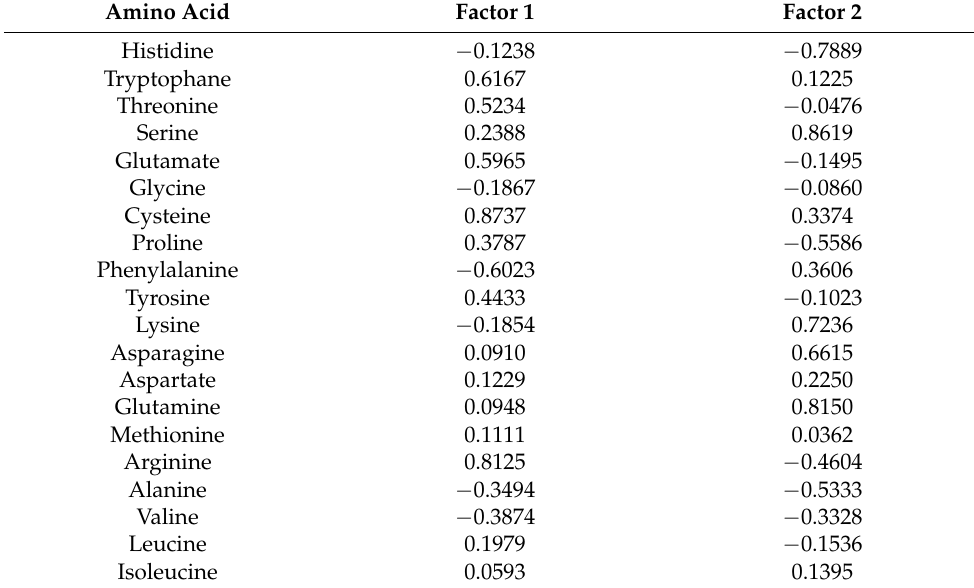
Table 2. Factor loadings of the first two factors of PCA (accounting for 66% of the total